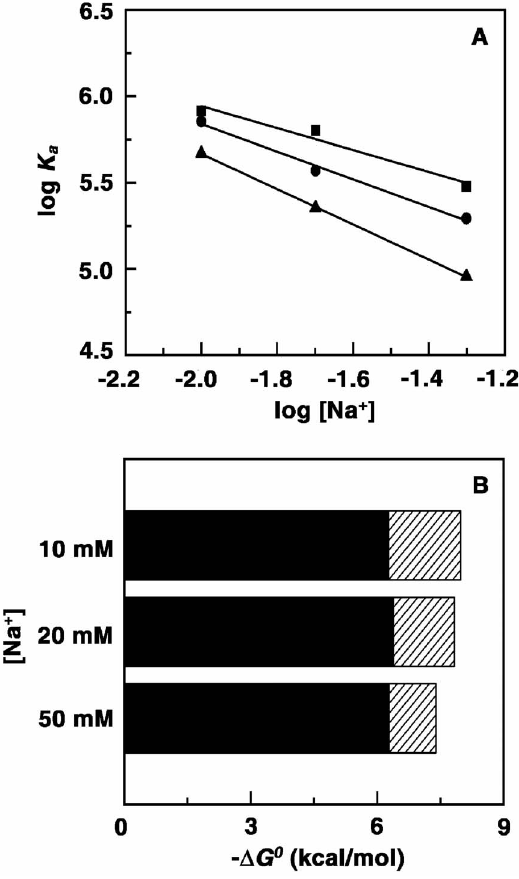
Figure 7. Plots of variation of salt dependent thermodynamic N parameters. (A) Plot of log K a versus log [Na + ] for the binding of ) and B4 ( m ) to tRNA and (B) partitioned analogs B2 ( & ), B3 ( polyelectrolytic ( D G 0 pe ) (shaded) and nonpolyelectrolytic ( D G 0 t ) (black) contributions to the Gibbs energy of the B4-tRNA complexation at different [Na + ]